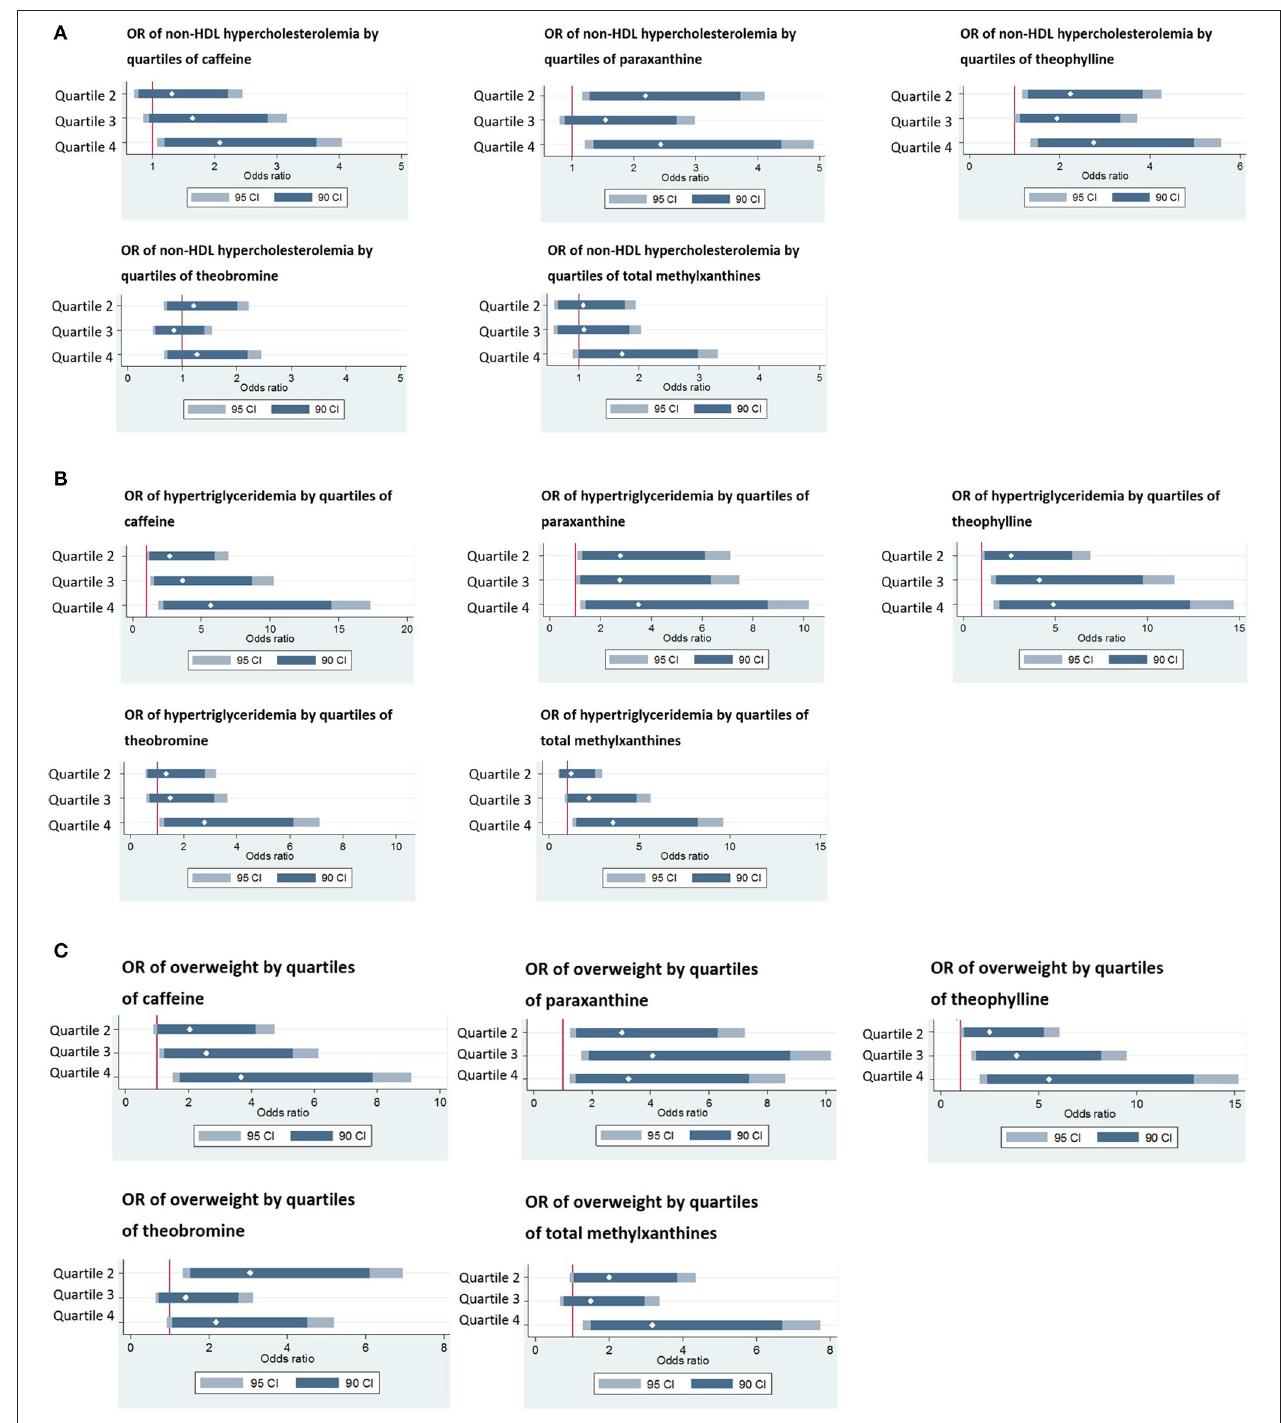
FIGURE 1 | (A) Odds ratio of non-HDL hypercholesterolemia (i.e., abnormal levels of plasma non-HDL cholesterol) by quartiles of plasma methylxanthines. Quartile 1 was considered as the reference. Odds ratio were adjusted for age, sex, smoking status, psychotropic medication, treatment duration and BMI. 95 CI: 95% confidence interval. 90 CI: 90% confidence interval. White diamonds represent estimates of adjusted odd ratio. Log caffeine: Q1: ≤ 4.43ng/ml; Q2: > 4.43– ≤ 6.03ng/ml; Q3: > 6.03– ≤ 7.32ng/ml; Q4: > 7.32ng/ml; Log paraxanthine: Q1: ≤ 5.1ng/ml; Q2: > 5.1– ≤ 6.23ng/ml; Q3: > 6.23– ≤ 7.07ng/ml; > 7.07ng/ml; Log theophylline: Q1: ≤ 3.43ng/ml; Q2: > 3.43– ≤ 4.31ng/ml; Q3: > 4.31– ≤ 5.16ng/ml; Q4: > 5.16ng/ml; Log theobromine: Q1: ≤ 5.55ng/ml; Q2: > 5.55– ≤ 6.44ng/ml; Q3: > 6.44– ≤ 7.17ng/ml; Q4: > 7.17ng/ml; Log total methylxanthine: Q1: ≤ 6.69ng/ml; Q2: > 6.69– ≤ 7.6ng/ml; Q3: > 7.6– ≤ 8.34ng/ml;